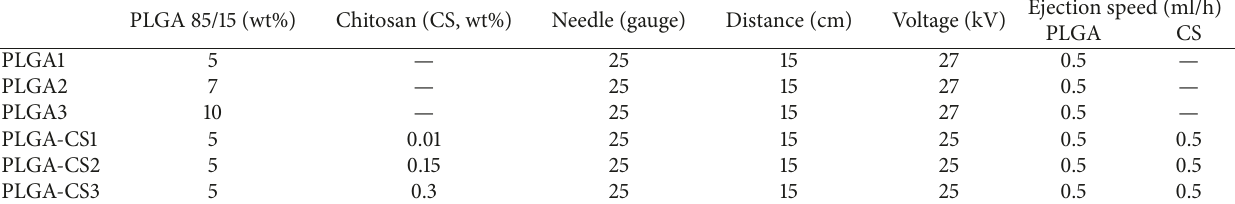
Table 1: Parameters of electrospinning.